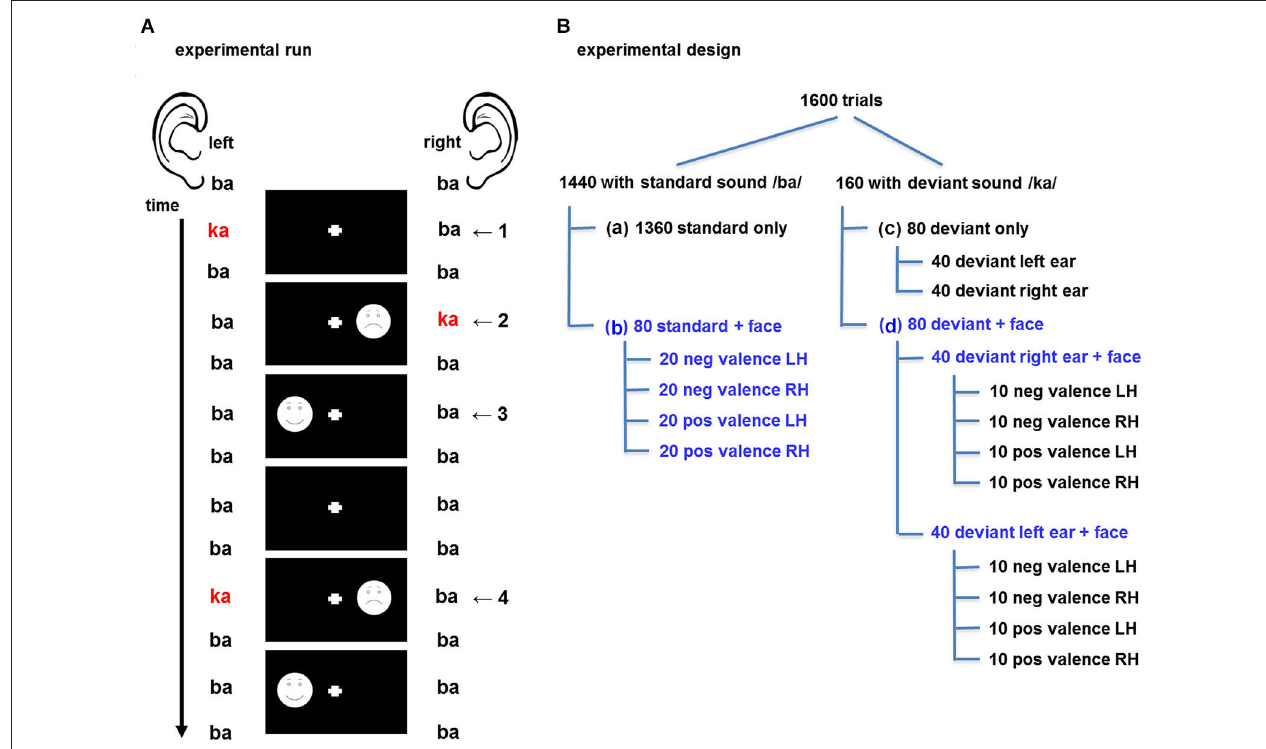
FIGURE 1 | (A) Design of the experimental run. A dichotic listening oddball paradigm was presented to elicit crossmodal cueing effects for the visuospatial stimuli. Auditory stimuli comprised the consonant-vowel syllables binaural /ba/ as standards and dichotic /ka/-/ba/, resp. /ba/-/ka/, as deviants. Schematic drawings of faces with positive and negative valence probed emotional salience effects. In the audio-only condition, the syllables and the fixation cross were presented (1). For spatially congruent (valid) stimuli, the deviant and the face were presented